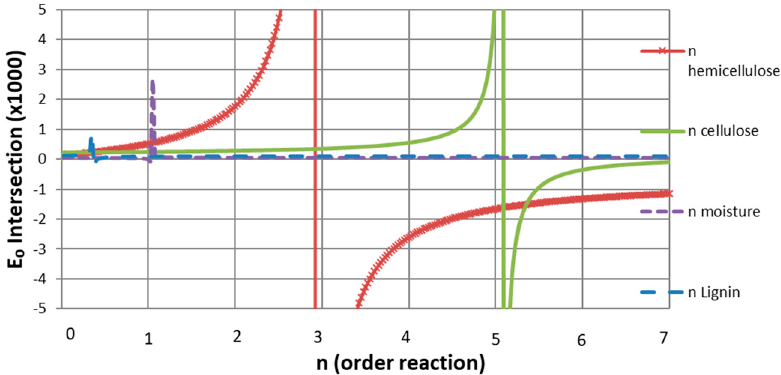
Figure 7. Common n-order reaction for each pseudo-component.